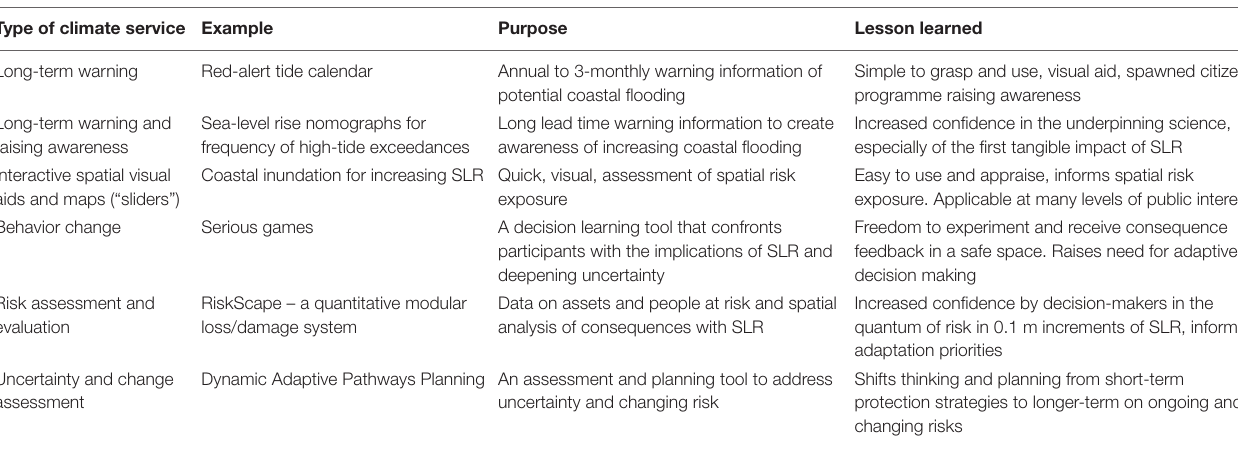
TABLE 3 | Type of climate service with examples, purpose and lessons